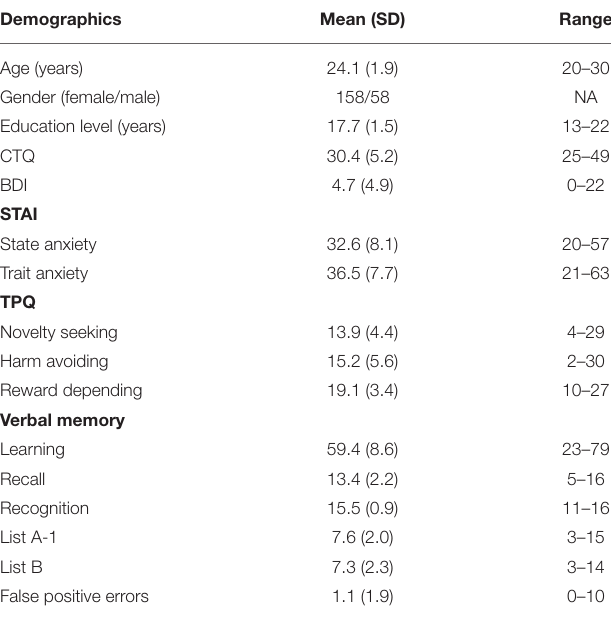
TABLE 1 | Demographic and behavioral characteristics of the sample.